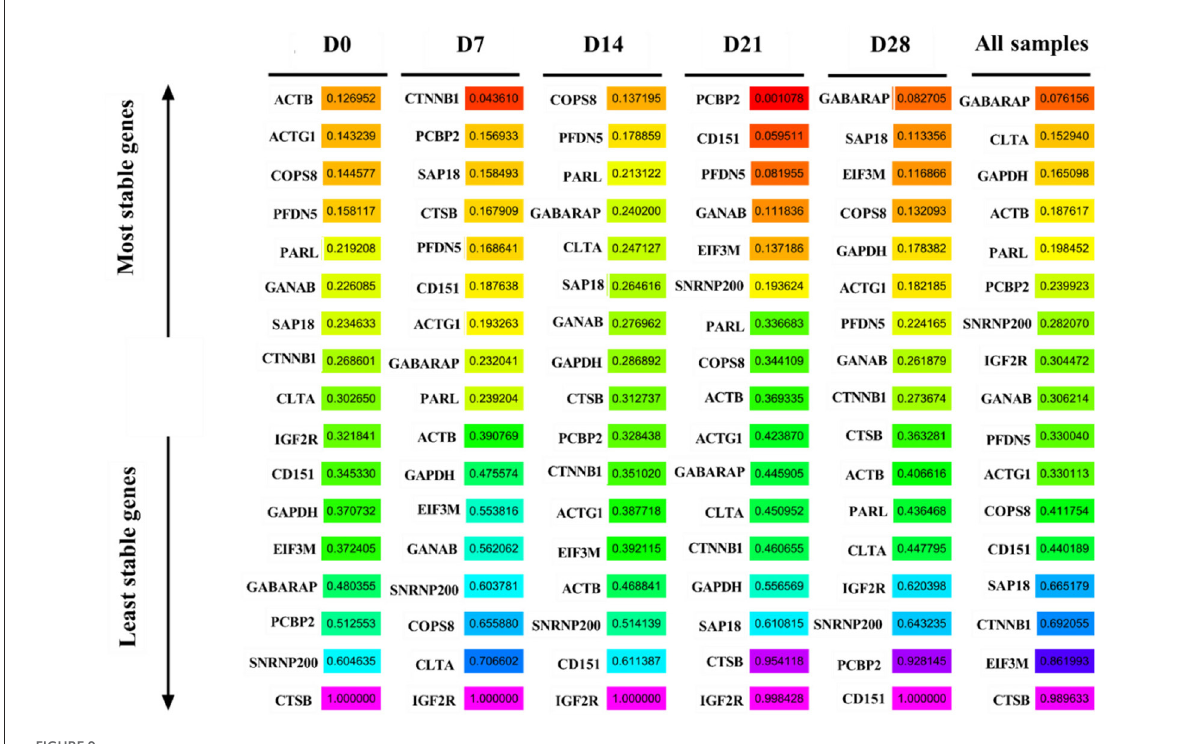
FIGURE9 ComFinder analysis the expression stability of candidate reference genes.